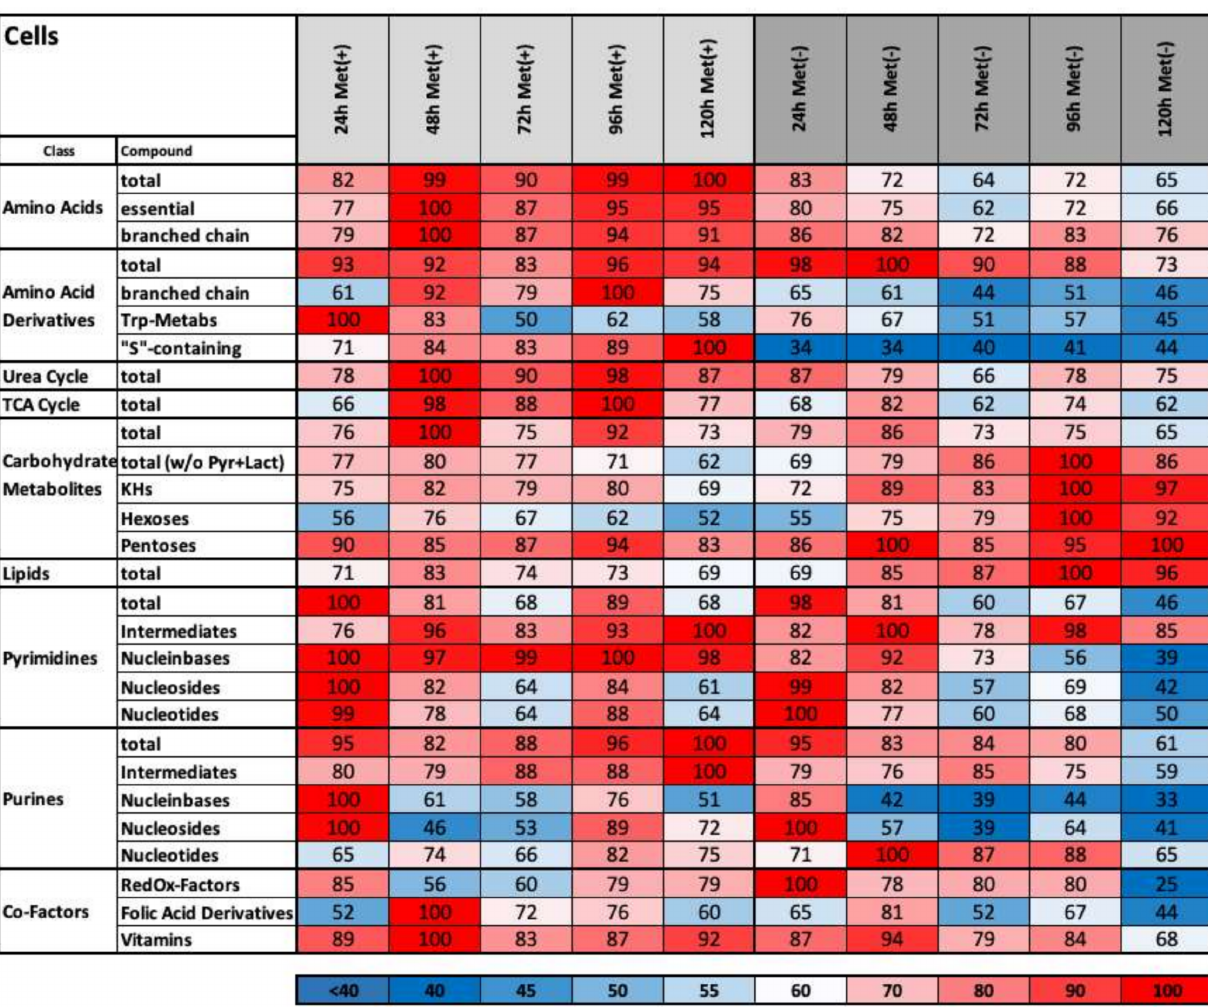
Figure 4. Heat map overview of the summarized metabolites belonging to different pathways in cell pellets. The percentages of the summarized metabolites belonging to the classes of amino acids, amino acid derivates, urea and TCA cycles, carbohydrates, lipids, pyrimidines, purines and cofactors were calculated as described in the Materials and